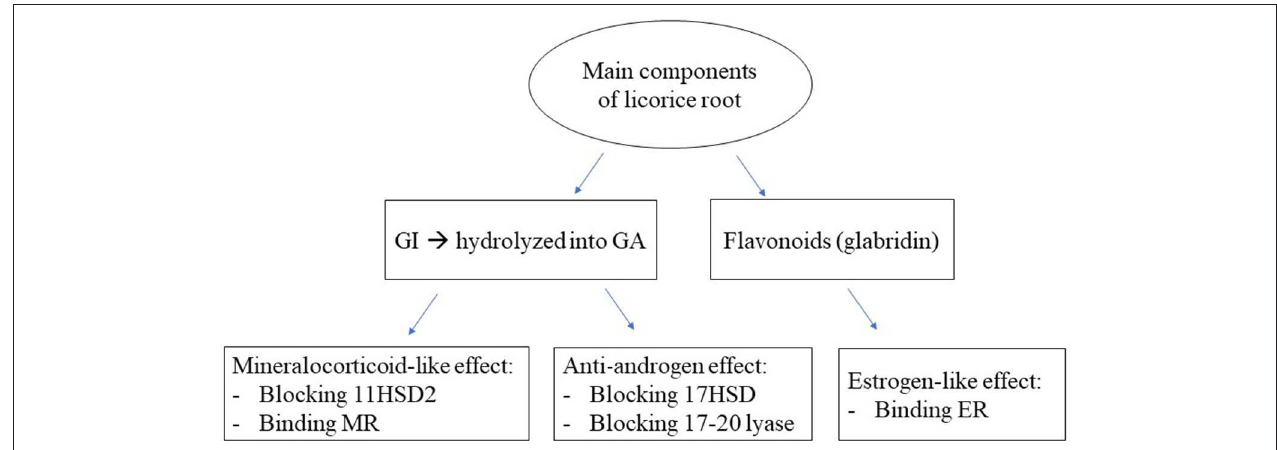
FIGURE 1 | Endocrine effects of the main components of licorice. GI, glycyrrhizic acid; GA, glycyrrhetinic acid; 11HSD2, 11 beta-hydroxysteroid dehydrogenase 2; MR, mineralocorticoid receptor; 17HSD, 17 hydroxysteroid dehydrogenase; ER, estrogen